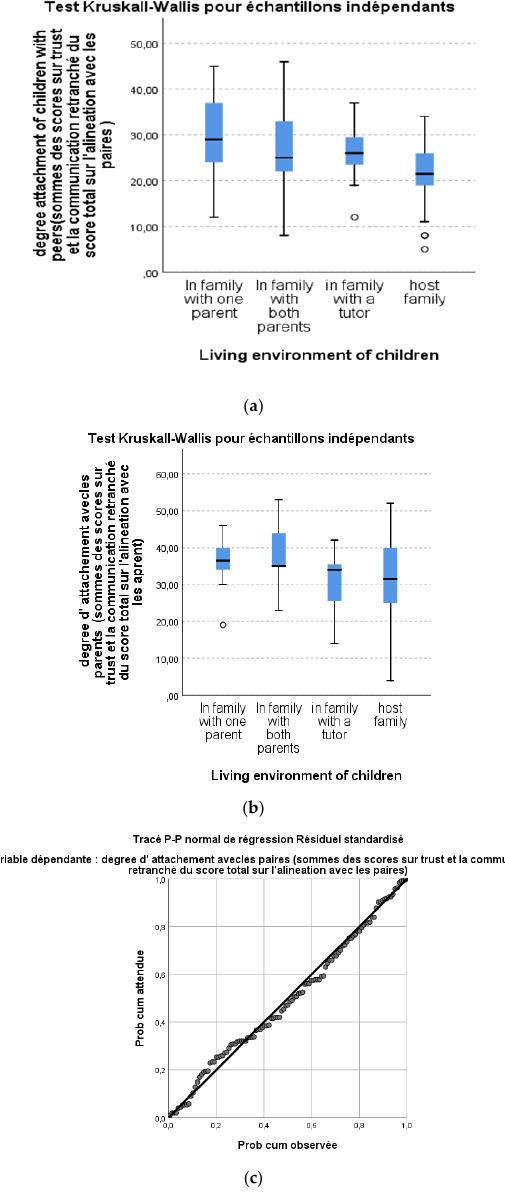
Figure 3. The Kruskall–Wallis boxplot for the degree of attachment representations with parents and their peers. ( a ) The distribution of the degree of attachment representations for children with their parents. ( b ) The distribution of the degree of attachment representations for children with their peers. ( c ) Normal p - p trace of standardized residual